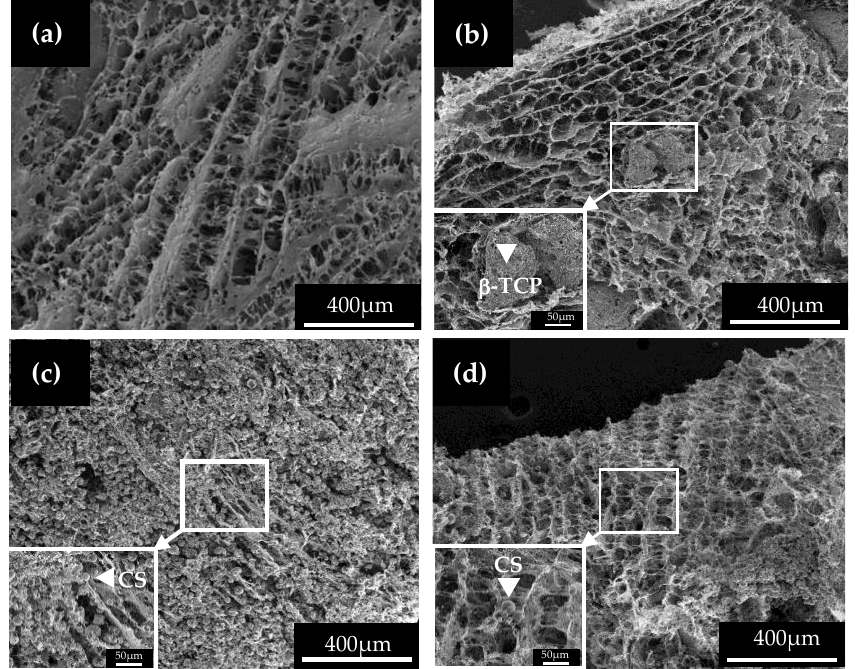
Figure 3. SEM images of ( a ) pure collagen scaffold, ( b ) collagen/ β -TCP, ( c ) collagen/CS, and ( d ) collagen/ β -TCP/CS composite scaffolds.